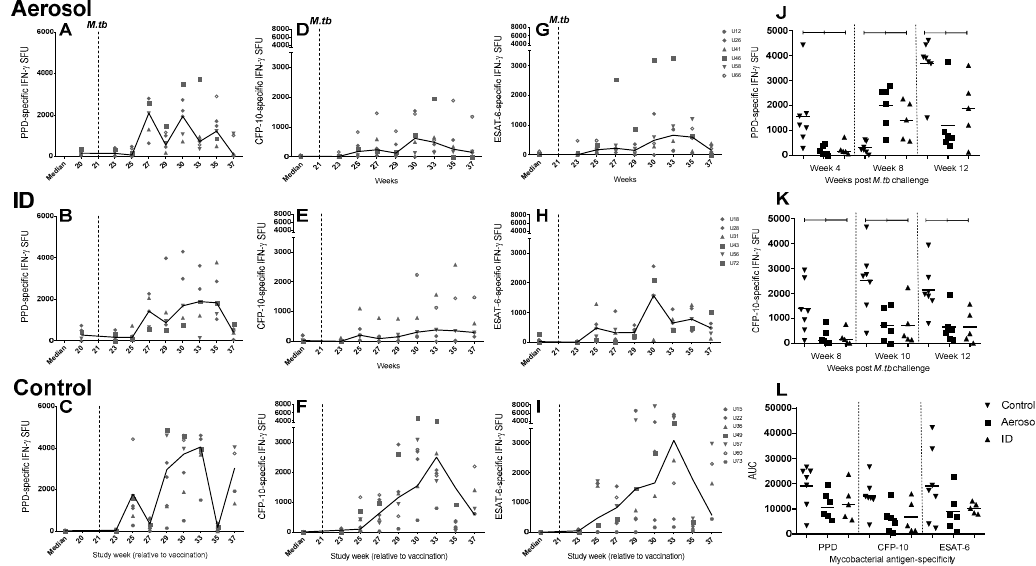
Figure 8. Systemic PPD-, CFP10- and ESAT-6-specific IFN- γ spot forming unit frequency measured by ELISpot assay following aerosol challenge with M. tuberculosis . Mycobacterial antigen-specific IFN- γ SFU measured in individual aerosol ( A , D , G ), or ID ( B , E , H ) BCG-vaccinated and unvaccinated control ( C , F , I ) animals during the post-challenge phase of the study (weeks 21–37) are shown as points with the vaccination group median line plotted. Ultra-low dose (ULD) aerosol M. tuberculosis challenge is indicated by a dotted line at study week 21. Plots J and K show PPD- ( J ) and CFP-10-specific ( K ) IFN- γ SFU frequencies between vaccinated and unvaccinated groups at specific weeks post- M. tuberculosis exposure, where significant di ff erences were measured by Mann–Whitney U-test ( p ≤ 0.05 ) . Plot L shows AUC values calculated for each vaccination group from the PPD-, CFP-10- and ESAT-6-specific response profiles following M. tuberculosis challenge. Group medians are indicated by horizontal lines and Mann–Whitney U-test significance is indicated by floating bars.